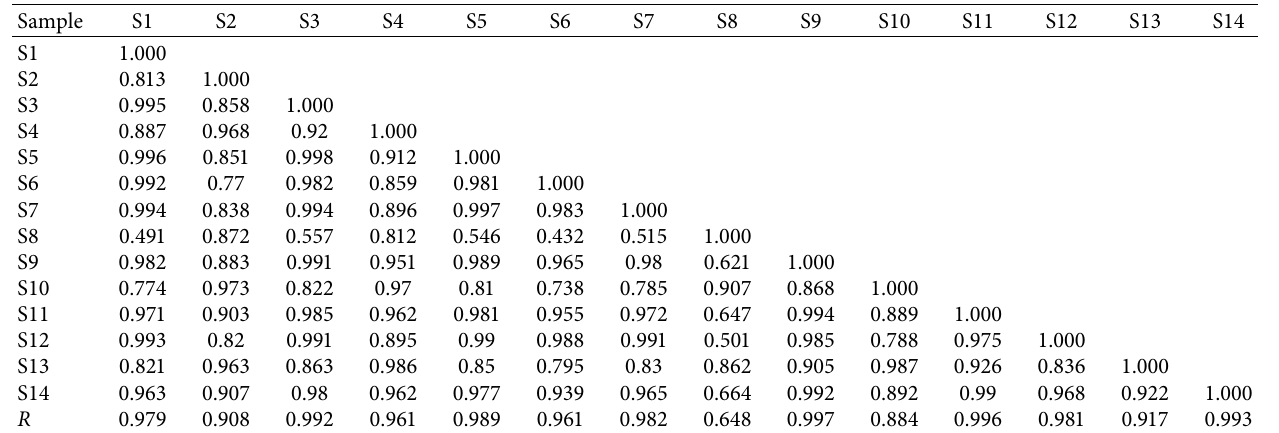
Table 6: Similarities of UPLC fngerprints.